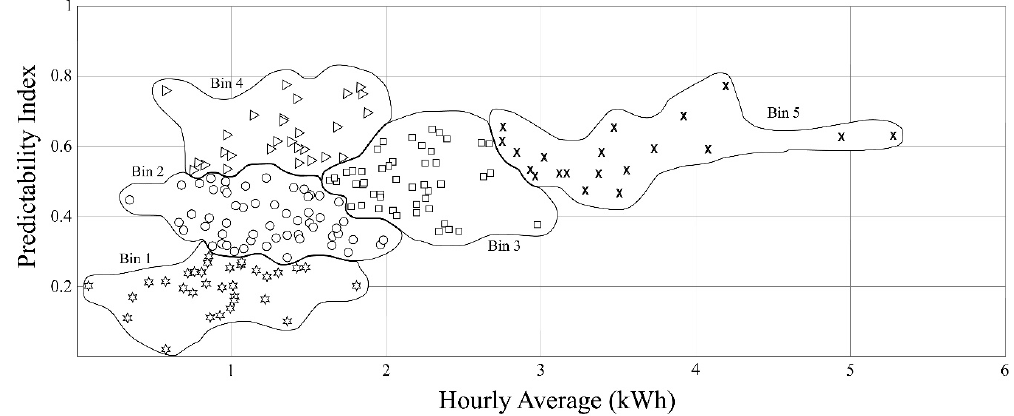
Figure 6. The relationship between average consumption level and predictability index.